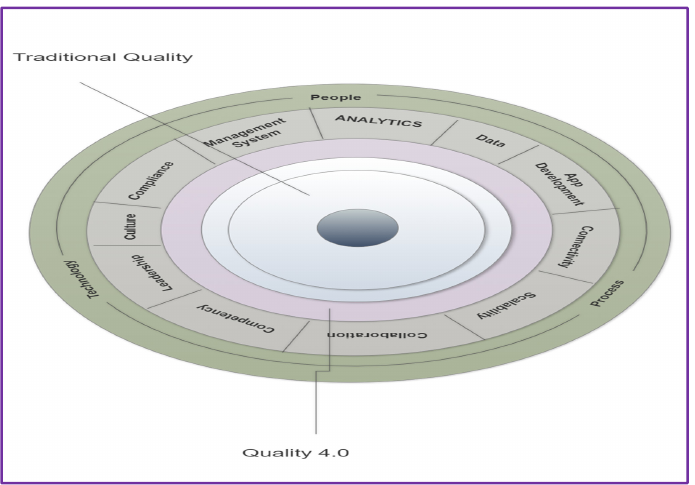
Figure 4. Eleven axes of Quality